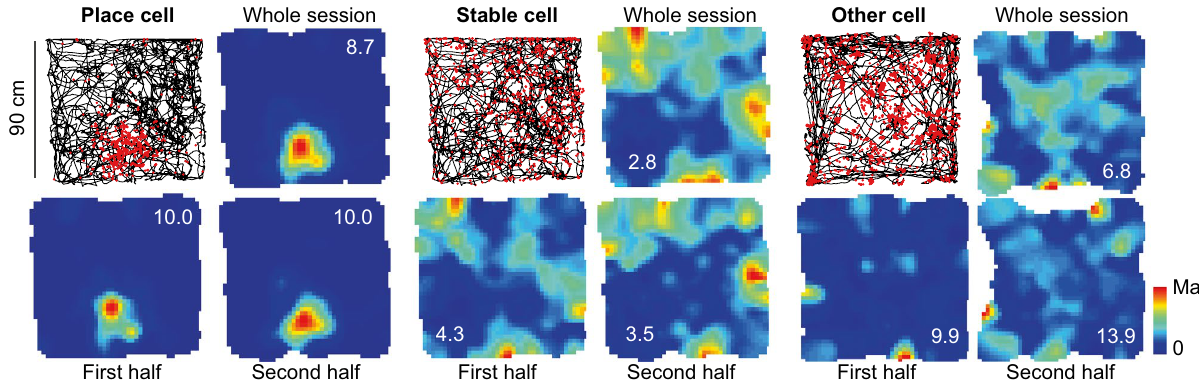
Figure 2. Spatial information and stability determine three cell categories. From left to right, an example of a place cell, a stable cell and a cell that is not informative or stable. For each cell, four maps are shown. Top: spike map (left) and rate map (right) for the data corresponding to the whole session. Bottom: rate maps for the first (left) and second (right) halves of the session.